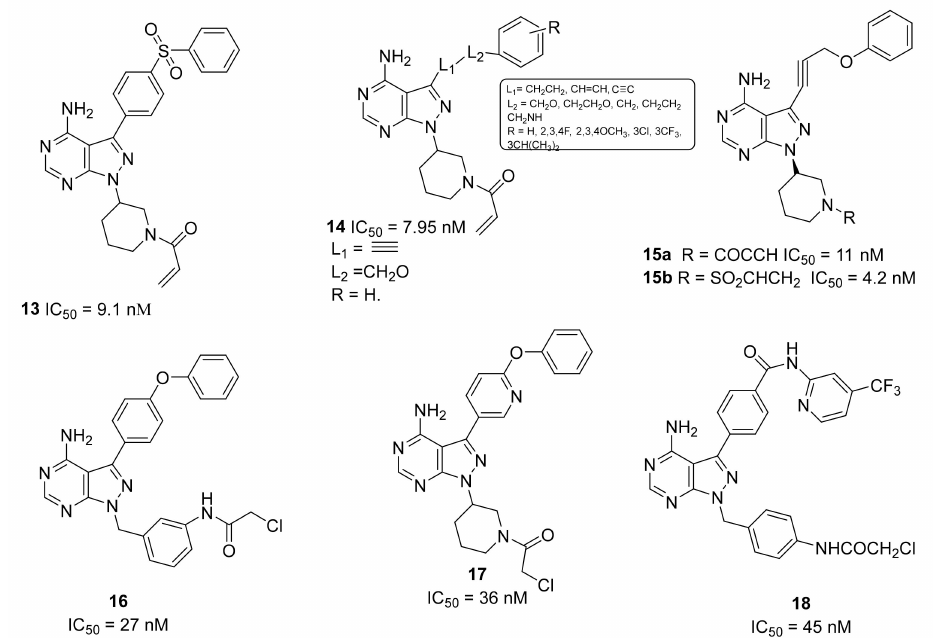
Figure 7. Pyrazolo-pyrimidine